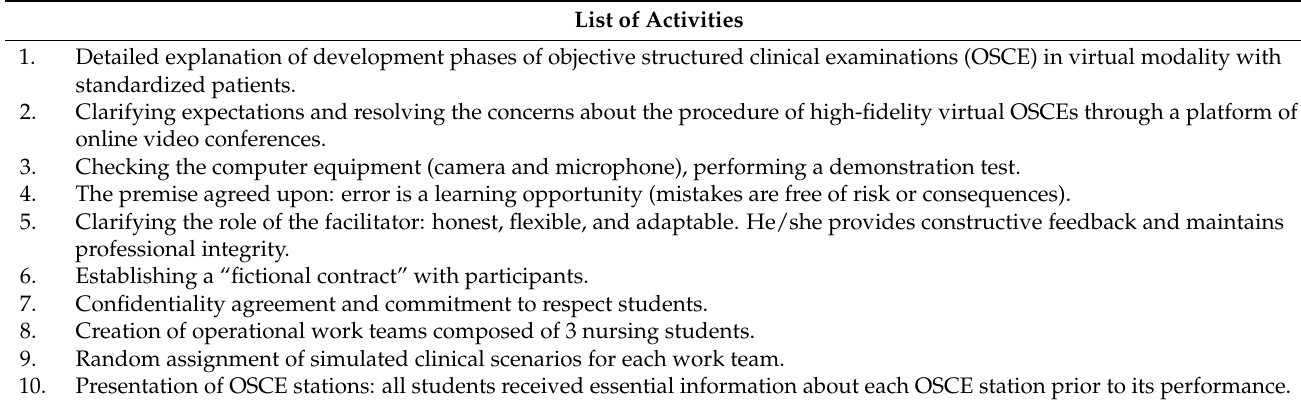
Table 1. Activities implemented for establishing a psychologically safe